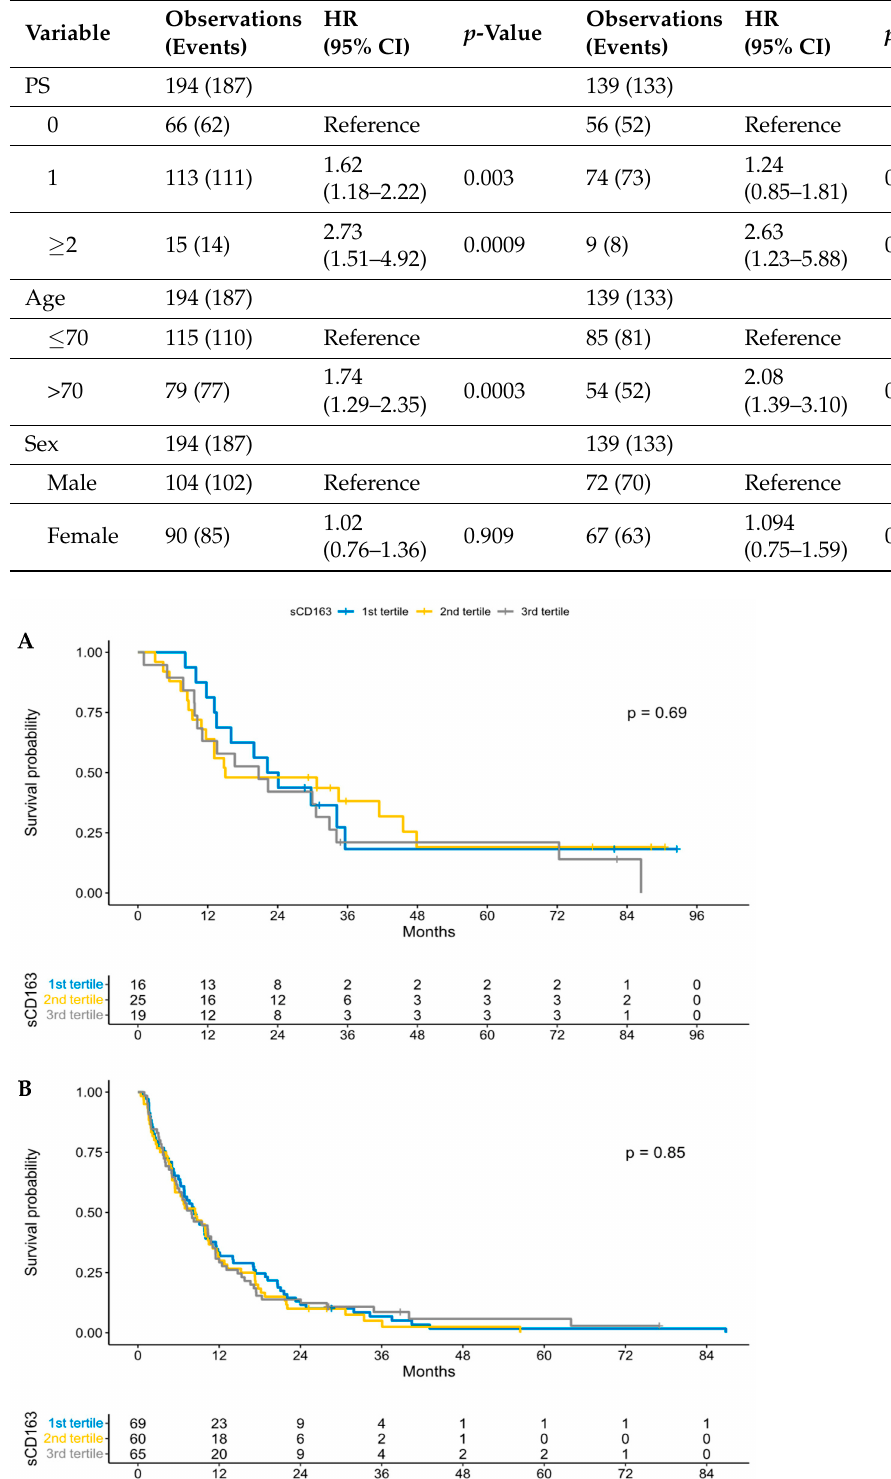
Figure 3. Kaplan–Meier survival curve showing overall survival according to sCD163 concentrations at time of diagnosis, divided into tertiles, ( A ) in patients with stage 1 + 2 pancreatic ductal adenocarcinoma and ( B ) stage 3 + 4 pancreatic ductal adenocarcinoma. Table 3. Univariate Cox regression analyses for overall survival according to sCD163, CRP, CA19- 9, IL-6 and YKL-40 concentrations (log-transformed), performance status, age, and sex, for patients with stage 1 + 2 pancreatic ductal adenocarcinoma.